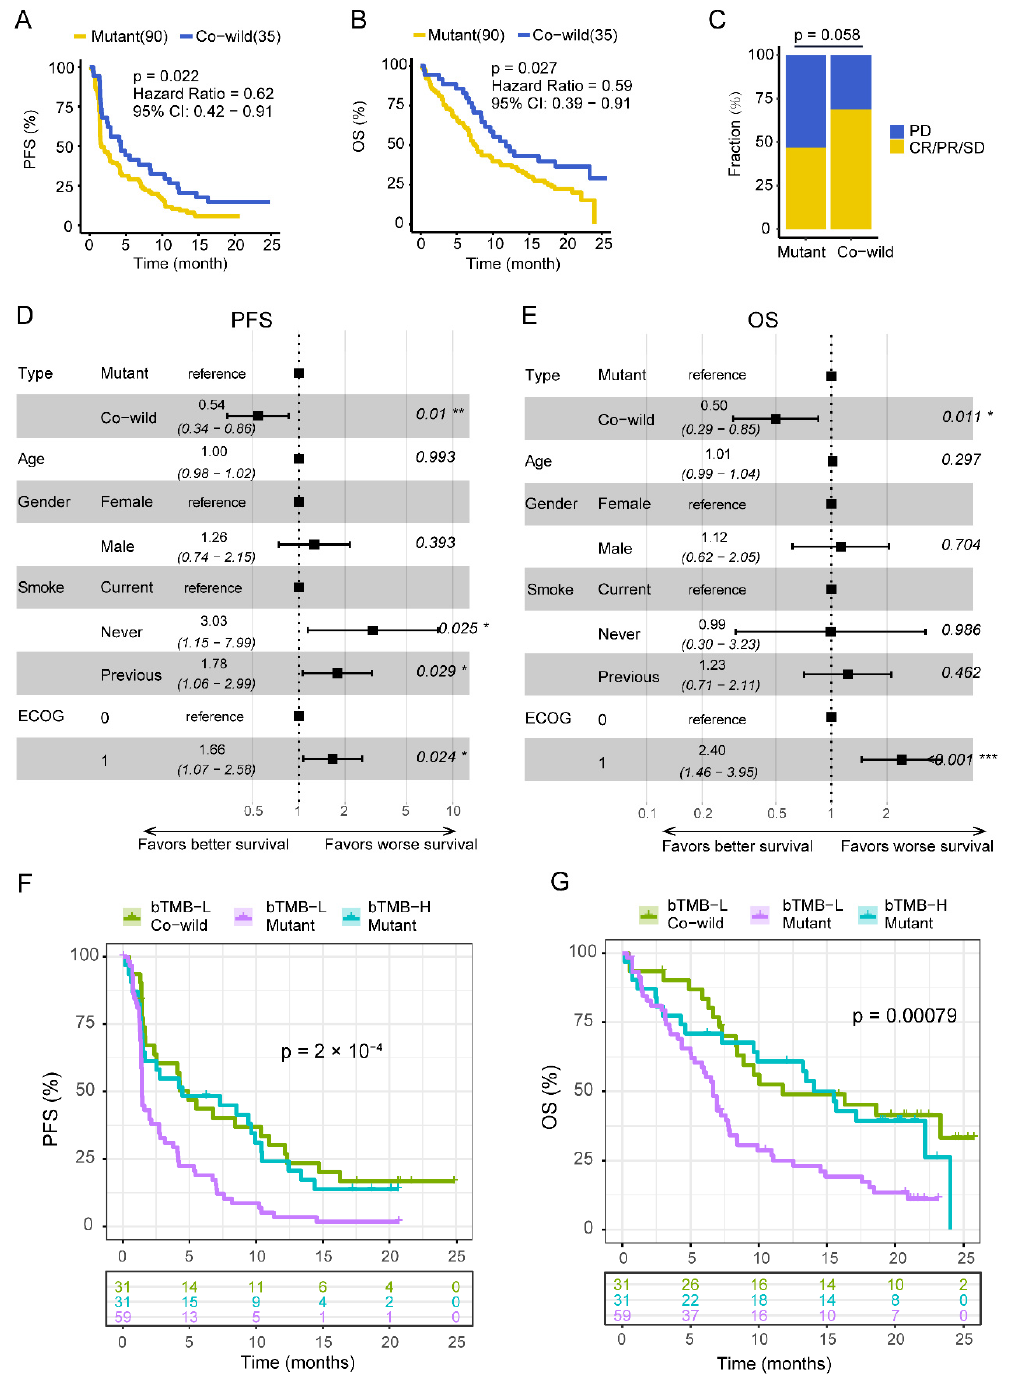
Figure 2. TP53 and LRP1B co-wild was associated with better immunotherapy outcomes. ( A , B ) The results of survival analysis on PFS and OS between TP53 / LRP1B mutant and co-wild LUSC in POPLAR/OAK cohort. ( C ) The differences of DCR between TP53/LRP1B mutant and co-wild LUSC in POPLAR/OAK cohort. ( D , E ) Multivariate cox regression analysis of PFS and OS, respectively. * p < 0.05, ** p < 0.01 and *** p < 0.001. ( F , G ) The results of survival analysis on PFS and OS among bTMB-H/mutant, bTMB-L/mutant, and bTMB-L/co-wild groups. PFS, progression-free survival; OS, overall survival; DCR, disease control rate; TMB-L, tumor mutational burden-low; TMB-H, tumor mutational burden-high.